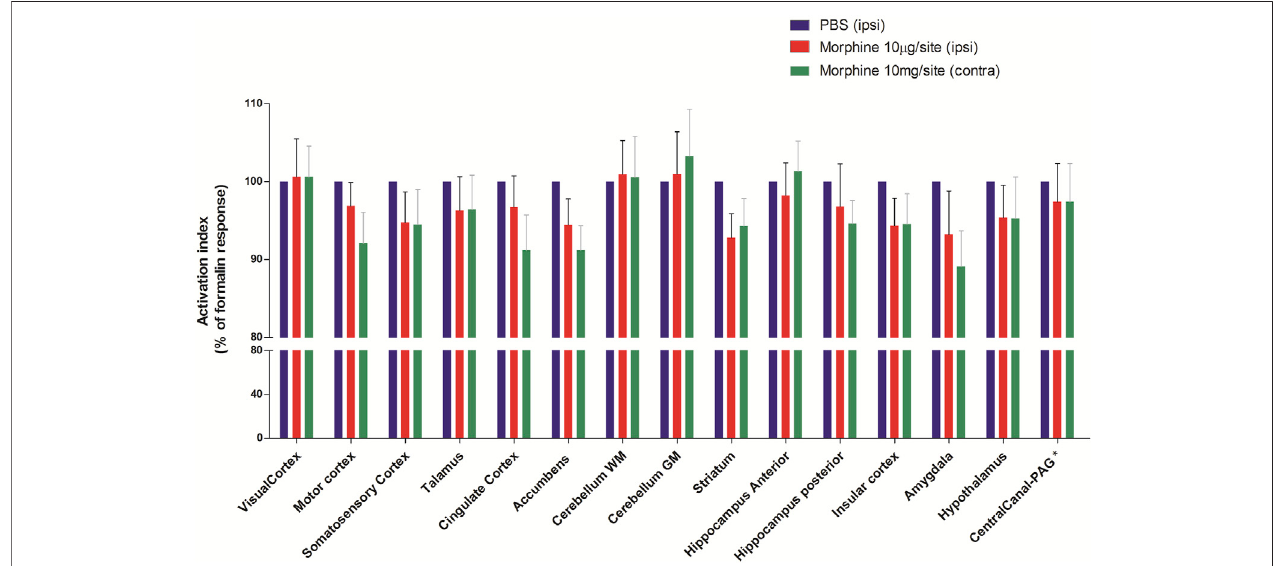
FIGURE 5 | Effect of pretreatment with Morphine on metabolic changes in different brain areas of rats induced by formalin. Bars represent mean+S.E.M. 18 F-FDG uptake normalised by the 18 F-FDG uptake in the group that received intrathecal PBS. Pretreatment with intrathecal Morphine (10 µg/site) led to a reduction in the metabolicactivityinsomeneuroanatomicregions,notablyintheamygdala,striatumandaccumebens.Thede fi nitionofcontraoripsilateralwasmadeinreferencetothe right paw where formalin or PBS was administered (N (cid:1) 6 and N (cid:1) 8, PBS and Morphine groups, respectivelly. ANOVAs with Fisher ’ s post hoc tests). WM: white matter, GM: gray matter, PAG: periaqueductal